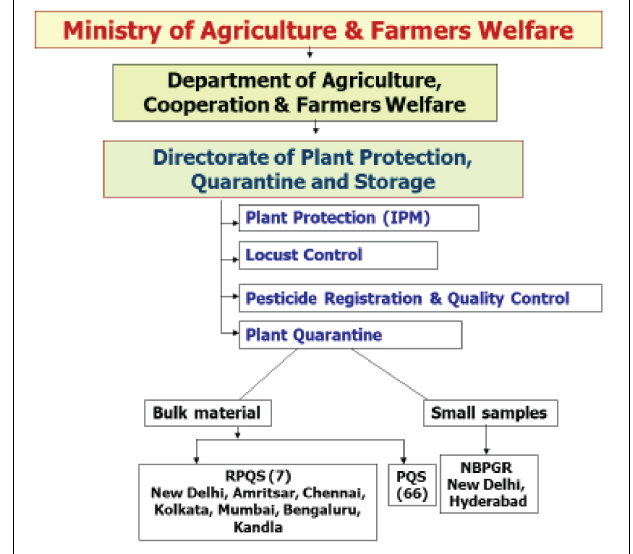
FIGURE 1 | The DPPQS organizational